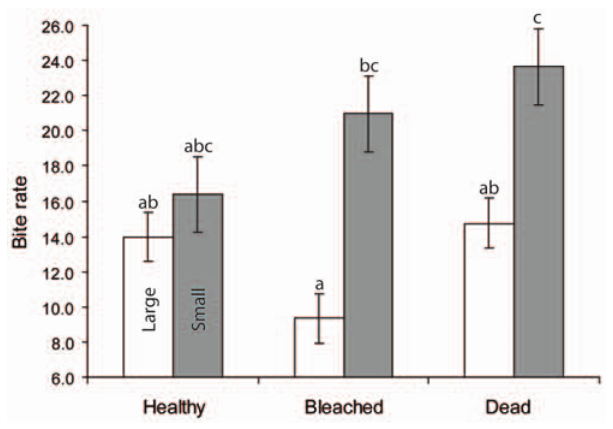
Figure 2. Influence of coral degradation and fish size on foraging rates. Comparison of bite rates (per 3 min) of large and small newly-settled Pomacentrus amboinensis on three different habitat patch types. Errors are standard errors.